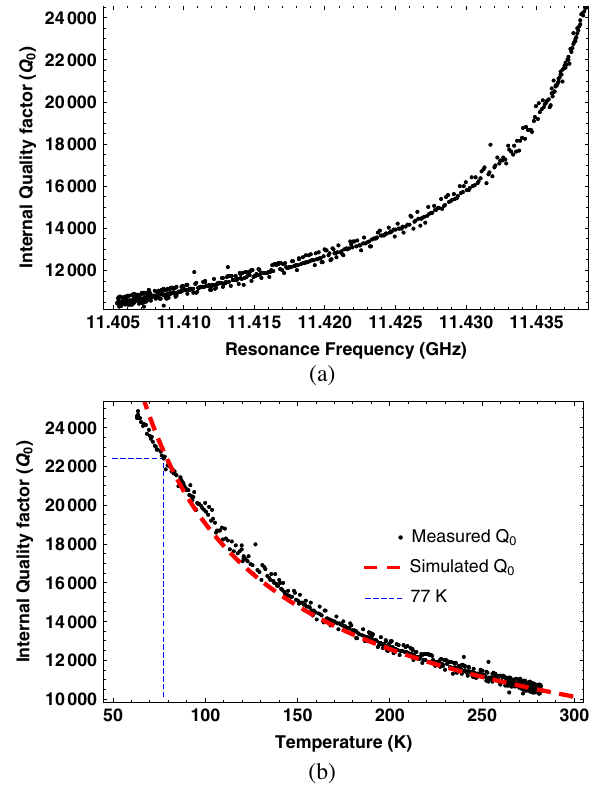
FIG. 4. (a) The measured intrinsic quality factor of the accel- erating structure versus the resonance frequency of the structure. The measured values are obtained using Q-circle fitting of the measured reflection coefficient at the rf input port. (b) We compared the measured values of the internal quality (black dots) with our simulations (dashed line). In our simulations, the temperature at each point is used to calculate the surface resistance using the theory of ASE and simulate the intrinsic quality factor.